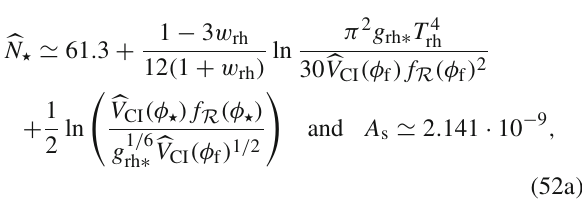
ized joint 68% [95%] regions from Planck , BAO and BK14 data [52] are depicted by the dark [light] shaded contours. For K = K 2 , K 4 and K 5 the results are obtained for φ (cid:21) (cid:4)